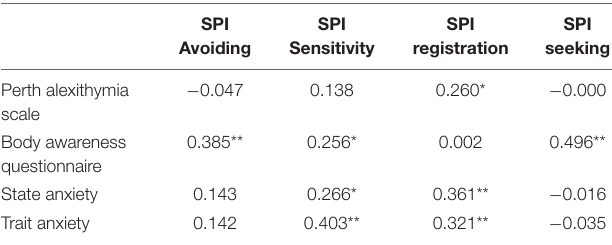
TABLE 4 | Correlations between alexithymia, body awareness, and anxiety to the Sensory Profile Interoception scale ( n =